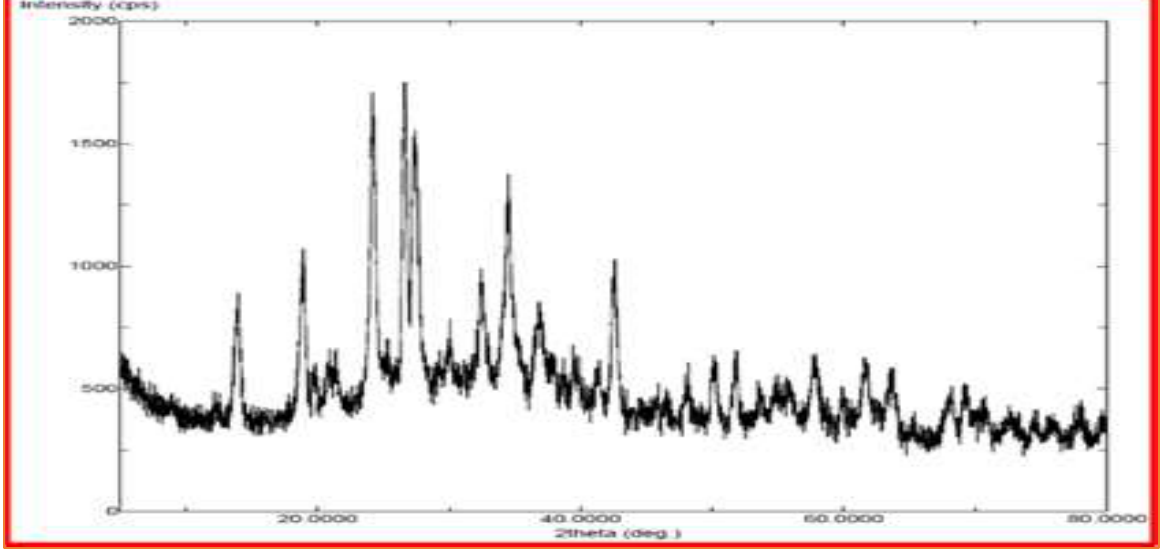
Figure 11. XRD diffraction of pure